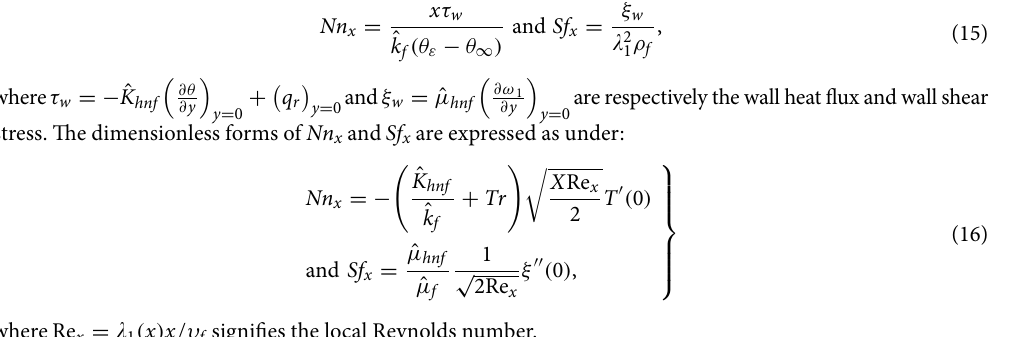
Numerical technique implementation. To illustrate physically consistent and stable numerical solution corresponding to transformed similarity Eqs. (11) and (12) satisfying the allied conditions (13) the finite differ- ence technique based bvp4c solver present in MATLAB is implemented. This solver was originally developed by Kierzenka and Shamoine 61 which works on three stages Lobatto IIIa algorithm. The algorithm results in 4th order accurate and uniform solution within the given range. The involved steps of the aforesaid method are furnished below: